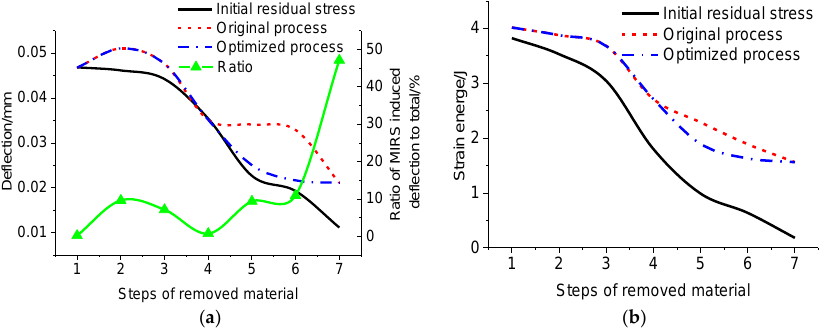
Figure 18. Deformation ( a ) and strain energy ( b ) varying with material removal.